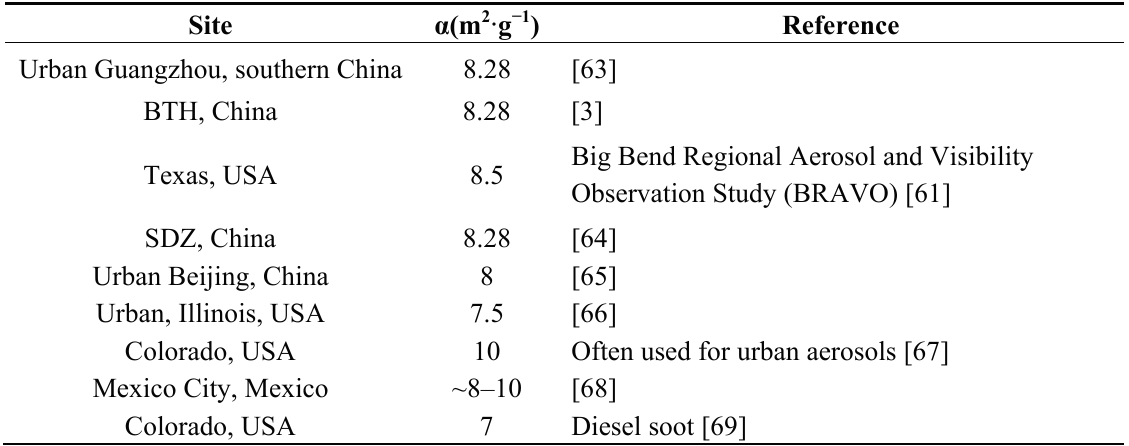
Table 3. BC absorption efficiency conversion factor α at different